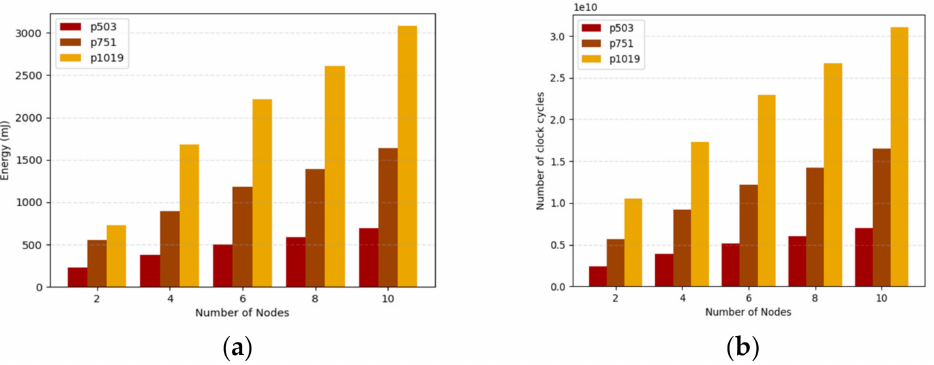
Figure 10. ( a )Energy consumption, ( b ) number of clock cycles in million cycles with number of